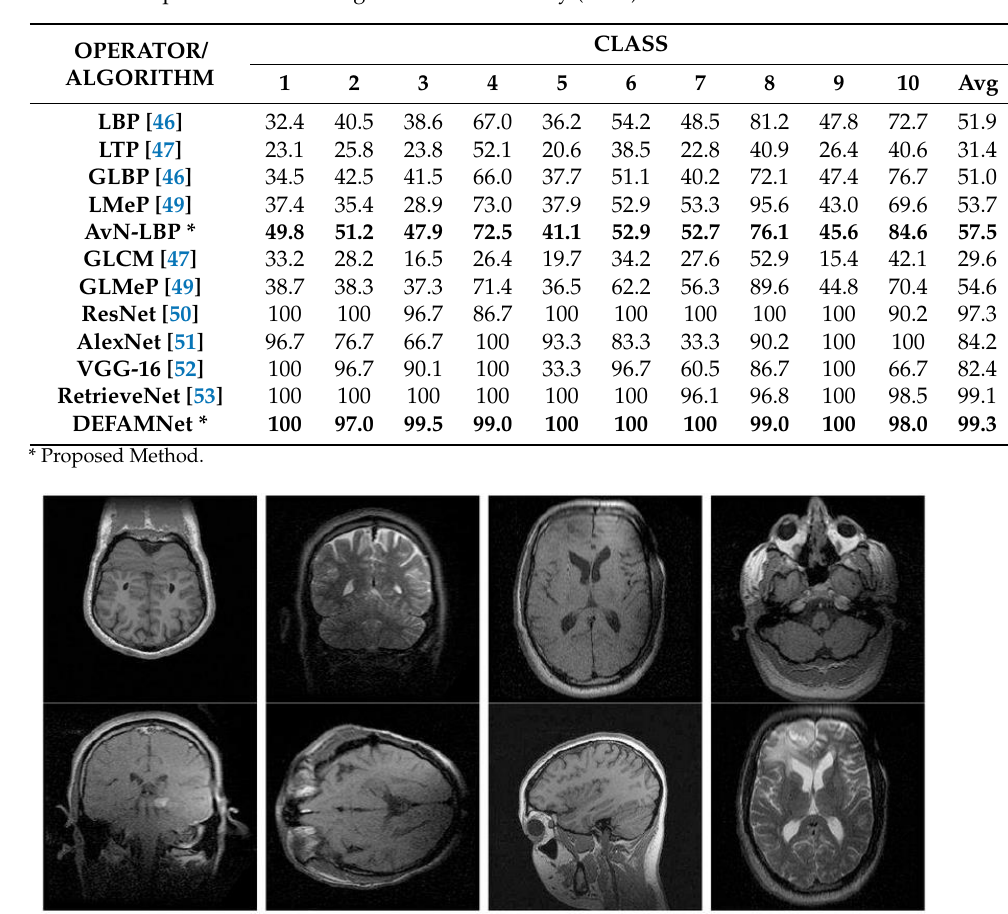
Table 3. Comparison of Percentage Retrieval Accuracy (ARR) on the I-ELCAP database.